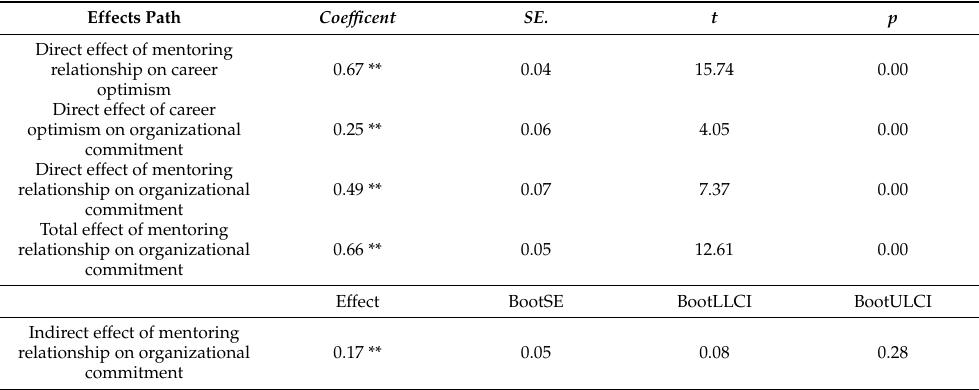
Table 3. The results of hierarchical